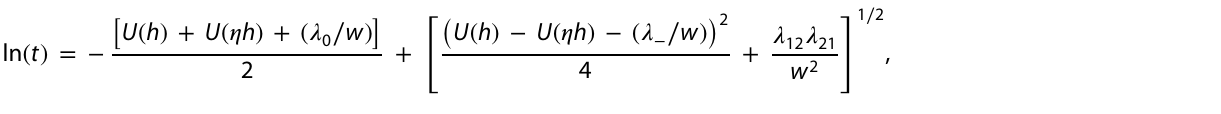
Fig. 3 Temperature dependence of the upper critical field obtained from R(T, H) data with the in-plane and out-of-plane orientations. Left panel show data for x = 0.12, right panel shows data for x = 0.15. Dash-dotted lines show the WHH model approximation. Dash lines